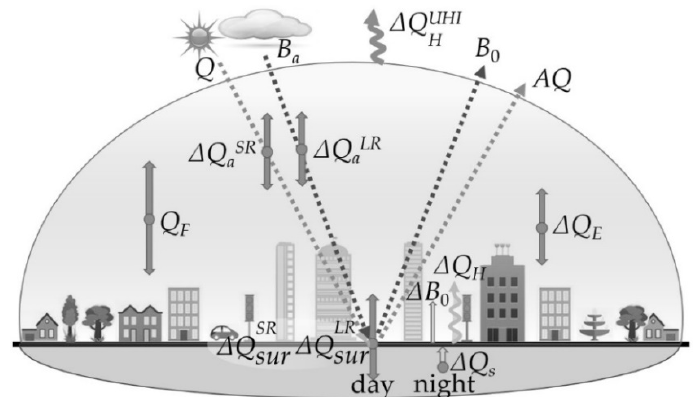
Figure 1. Main changes in the heat and radiation fluxes at the urban underlying surface that cause the formation of the urban heat island.